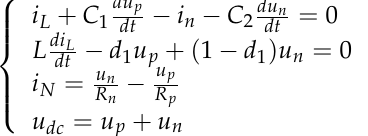
Figure 7. Block diagram of multi-node bipolar DC distribution network with consensus control.